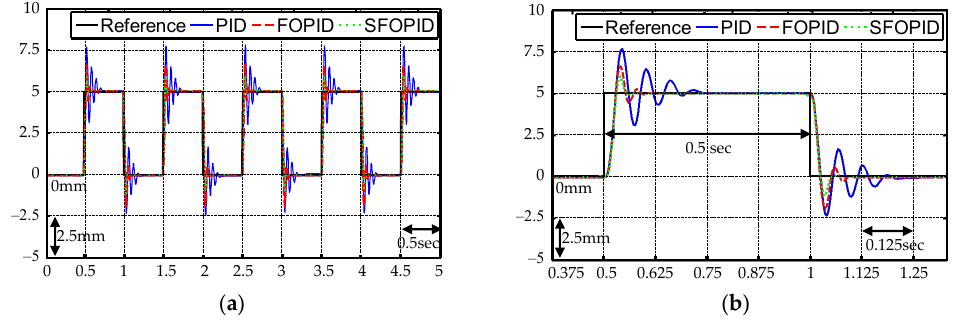
Table 2. Performance measures and improvement rates for the sinusoidal reference tracking of various VCM control systems in Case 2.